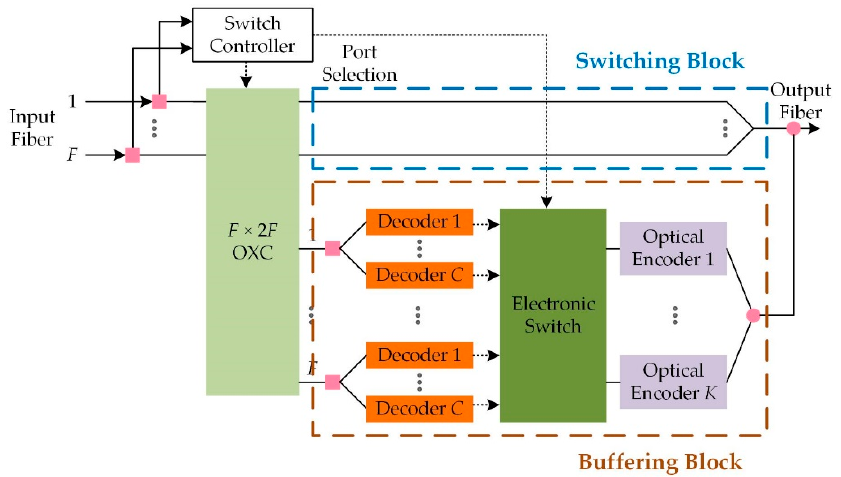
Figure 2. Node architecture with packet buffering based on residual-coded label switching.